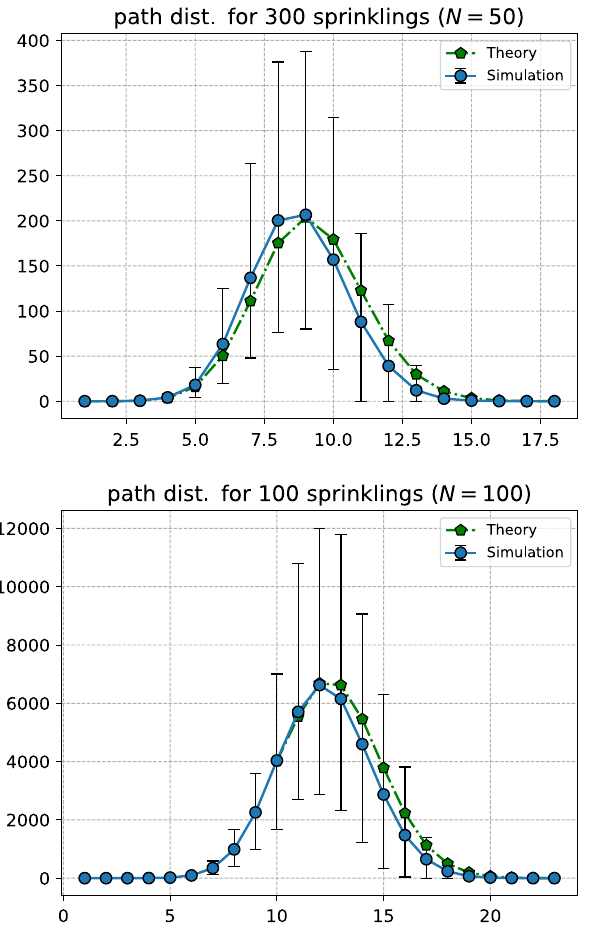
Fig. 1 A comparison of the average path length distributions for 300 sprinklings of 50 points and 100 sprinklings of 100 points, on the top and bottom figures respectively, withtheircorresponding analyticaldis- tributions. Due to numerical error, the theory curve starts at k = 9